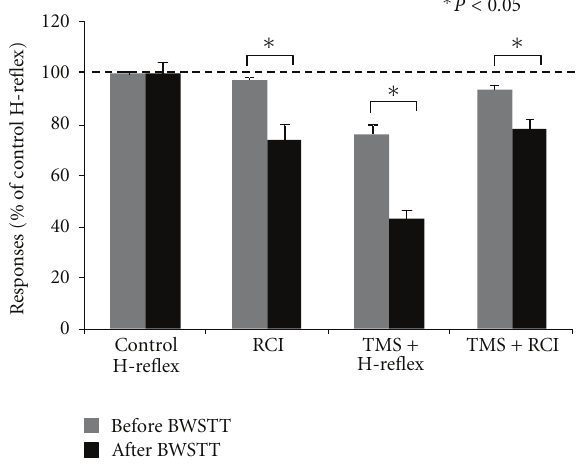
Figure 4: Cortical control of spinal reflex circuits after locomotor training in SCI. Mean size ( n = 20) of soleus H-reflex conditioned by common peroneal nerve stimulation at the conditioning- test interval of 3 ms, which reflects the amount of reciprocal Ia inhibition (RCI), soleus H-reflex conditioned by subthreshold TMS (TMS+H-reflex) at a C-T interval of 1 ms, and reciprocal inhibition conditioned with subthreshold TMS (TMS+RCI) at C- T intervals of 1 and 3ms, respectively. Data are from the same patient. The size of the conditioned H-reflexes is expressed as a percentage of the mean amplitude of the control soleus H-reflex. Error bars indicate the SEM, and asterisks denote a statistically significant di ff erence (paired t -test, P < 0 . 05) for conditioned H- reflexes recorded before and after 60 BWSTT